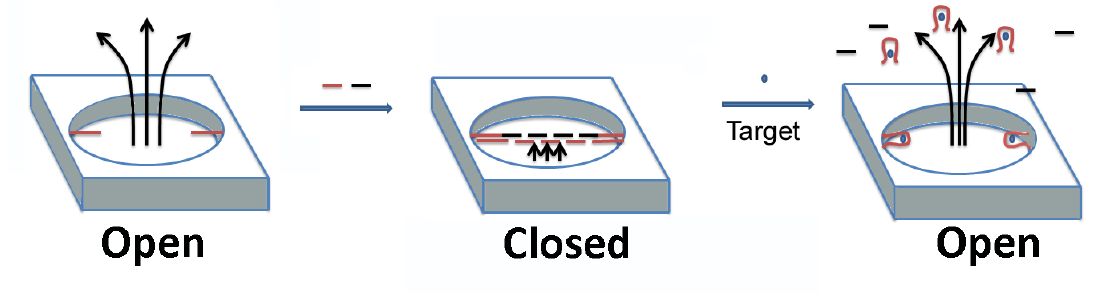
Figure 4. An aptamer-gated nanopore. DNA strands (red) based on the ATP aptamer act as capture probes on an alumina channel wall. Introduction of linking strands and more ATP aptamers (black and red, respectively) lead to the formation of long concatamers through DNA hybridization. These long DNA duplexes block the transport of any ions through the channel. Upon addition of ATP, binding of the aptamer with the target causes the long concatamer to disassemble, opening up the pore and allowing ion transport. (modified from reference